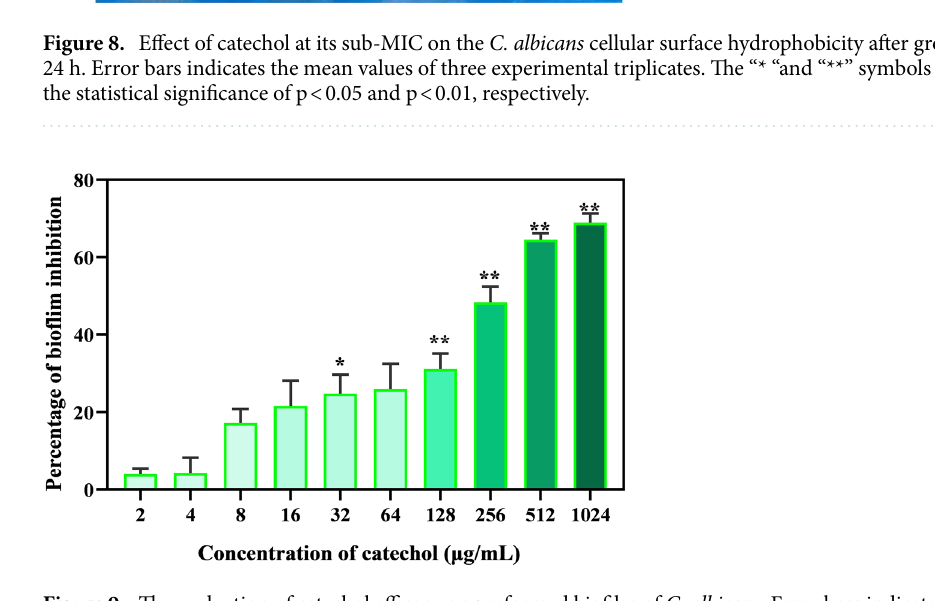
Figure 9. The evaluation of catechol efficacy on preformed biofilm of C. albicans . Error bars indicates the mean values of three independent experiments performed in triplicates. The “* “and “**” symbols represents the statistical significance of p < 0.05 and p < 0.01,